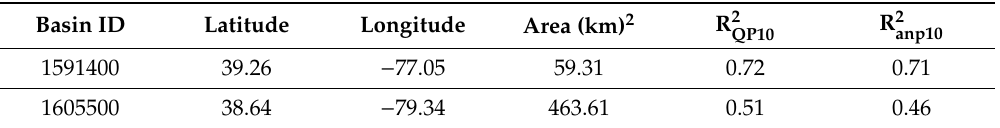
Table A1. Coe ffi cient of correlation between k (recession constant) and past discharge and between k and past total water storage from GRACE. Column 1 gives basin ID. Columns 2 and 3 are the latitude and longitude of the gauging station of the basin. The 4th column is the drainage area of basin in square miles. The 5th column is the correlation between k and past average discharge between 2 and 10 days of discharge from peak discharge. The 6th column is the correlation between k and corresponding past average total water storage from